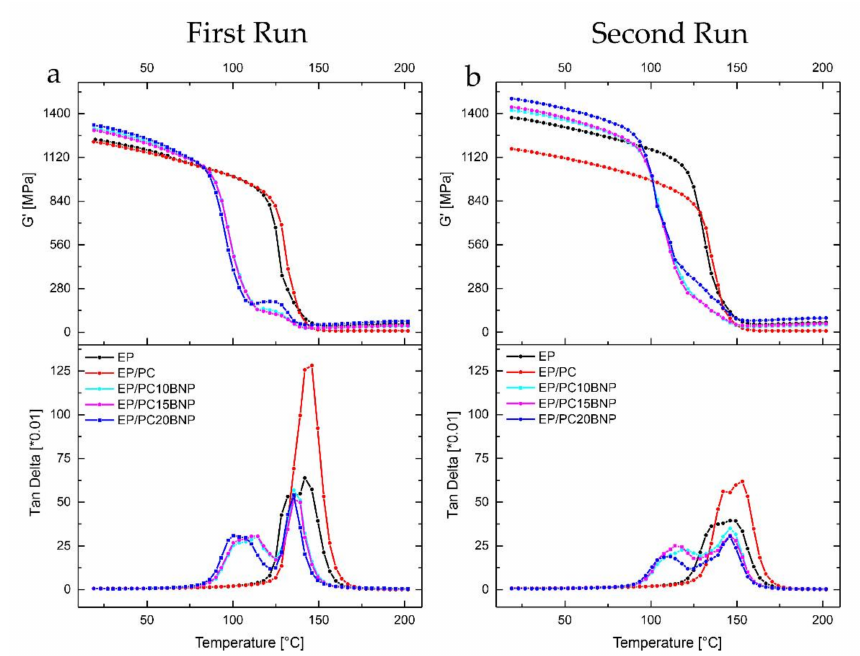
Figure 6. ( a ) Storage modulus G (cid:48) and loss factor Tan δ during the first run for neat Epoxy and the EP/PC/BNP fiber composites; ( b ) Storage and loss factor Tan δ during the second run for neat Epoxy and the EP/PC/BNP fiber